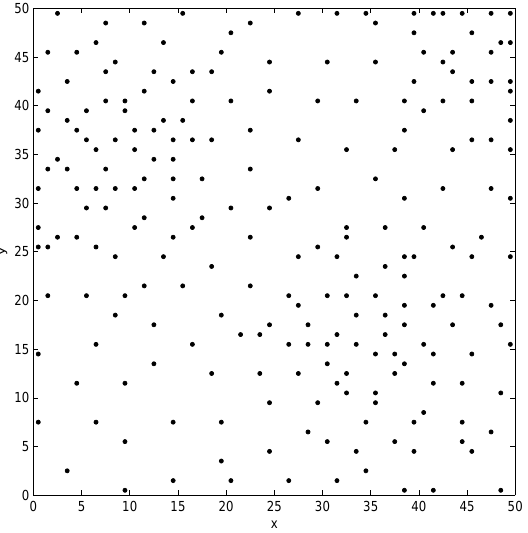
Figure 3. Tabu Search approach: Sensors positions